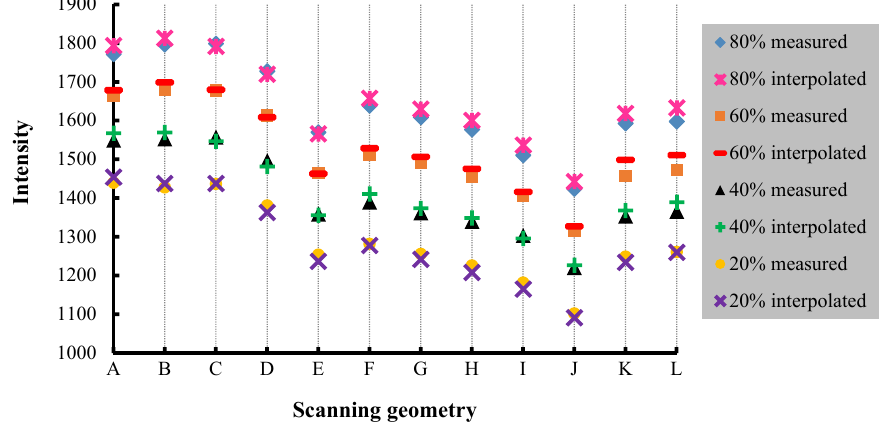
Table 2. Four reference targets scanned at other incidence angles and distances referred to A–L.